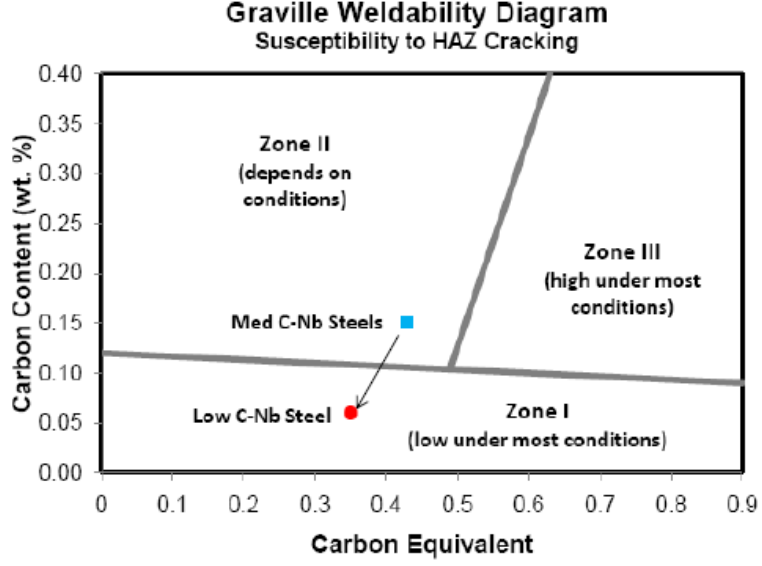
Figure 14. Graville weldability diagram [24].